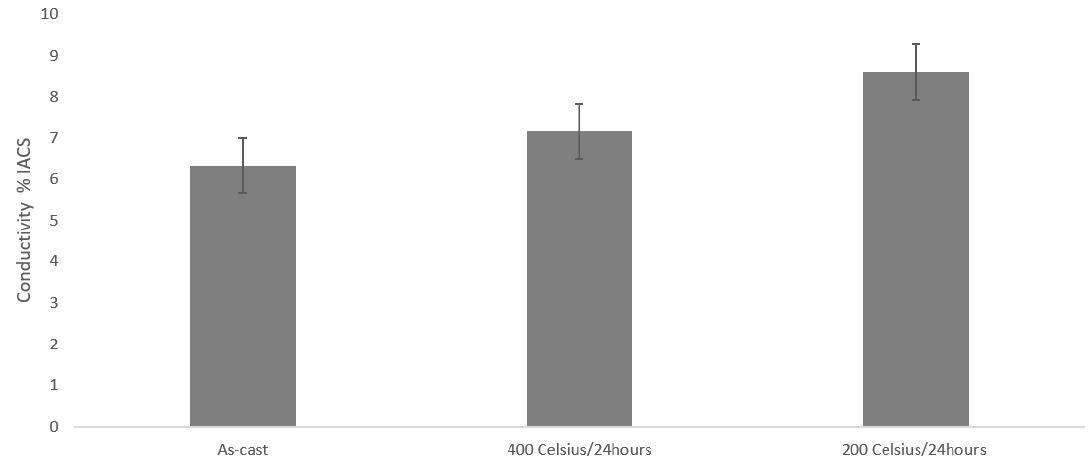
Figure 14. Conductivity measurements of 1M, 1MH and 1MH’ specimens.